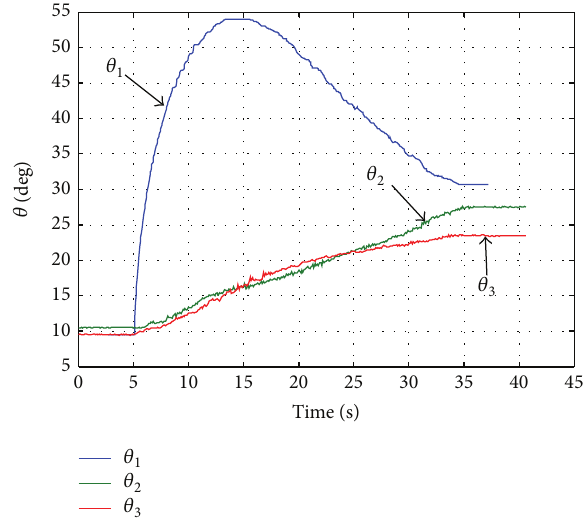
Figure 16: Joints angular displacement with initial errors (experi- ment